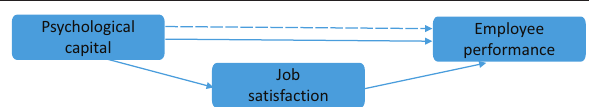
Employee performancePsychological